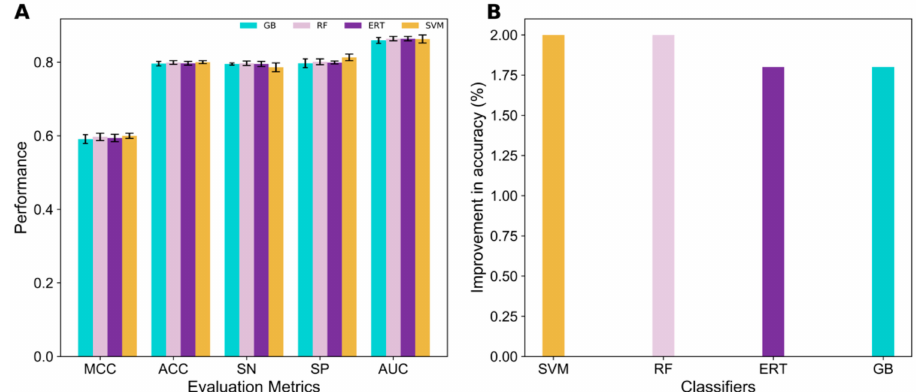
Figure 4. Meta-predictor performance and its improvement. ( A ) The performance comparison between four meta-predictors that utilize 28 probabilistic features as an input. ( B ) Improvement in the accuracy of each meta-predictor with respect to the baseline